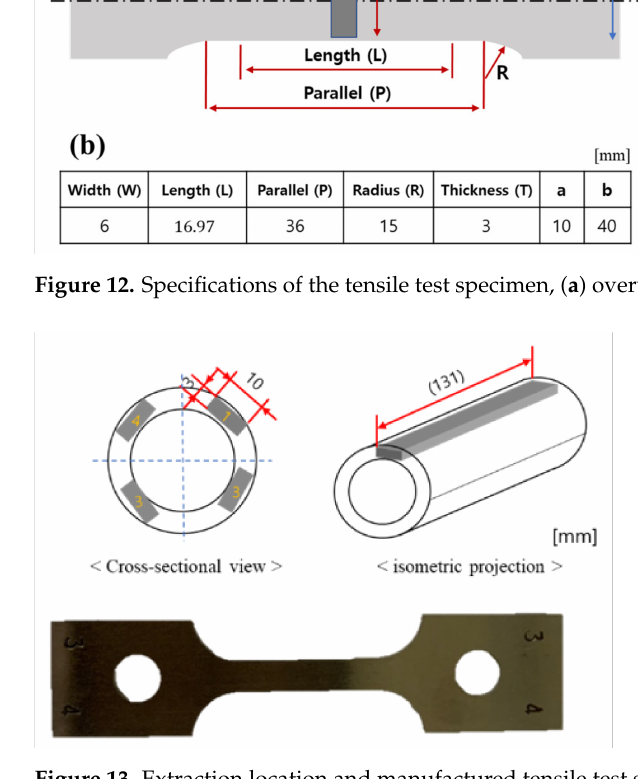
Figure 13. Extraction location and manufactured tensile test